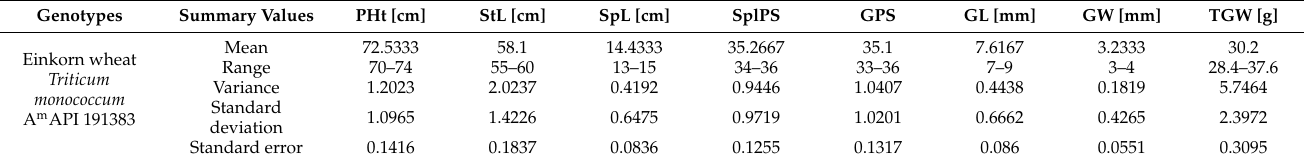
Table 6. Statistics, analysis of variance followed by Tukey’s Honest Significant Difference test (HSD) of 8 yield-related traits investigated among 60 plants of Triticum monococcum (PI 191383), Secale cereale (Dankowskie Hadron) and amphiploids (S4 generation): plant height (PHt), stem length (StL), spike length (SpL), number of spikelets per spike (SplPS), number of grains per spike (GPS), grain length (GL), grain width (GW) and thousand-grain weight